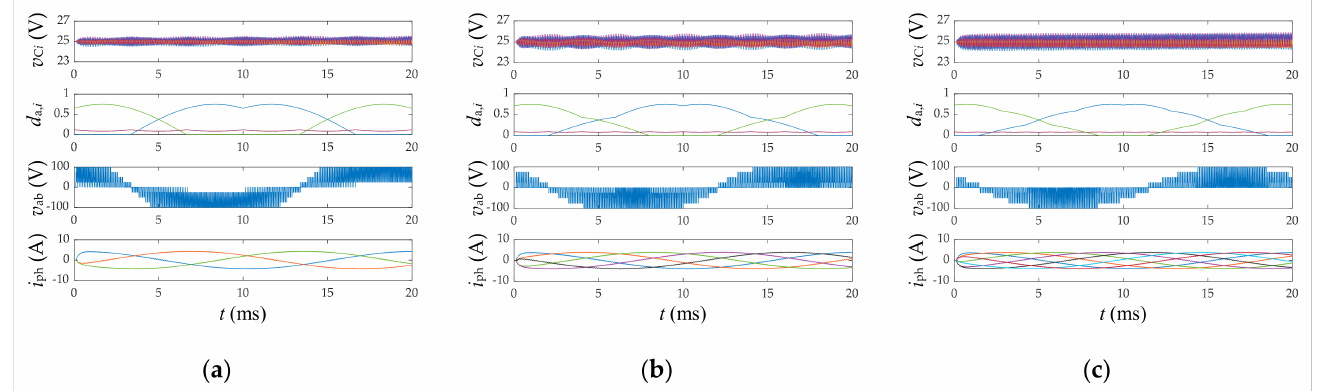
Figure 7. Simulation results for an NPC DC–AC conversion system, operated with the proposed VVPWM strategy formulation, under m = 0.75, n = 5, and different numbers of phases. ( a ) Three phases; ( b ) five phases; ( c ) seven phases.